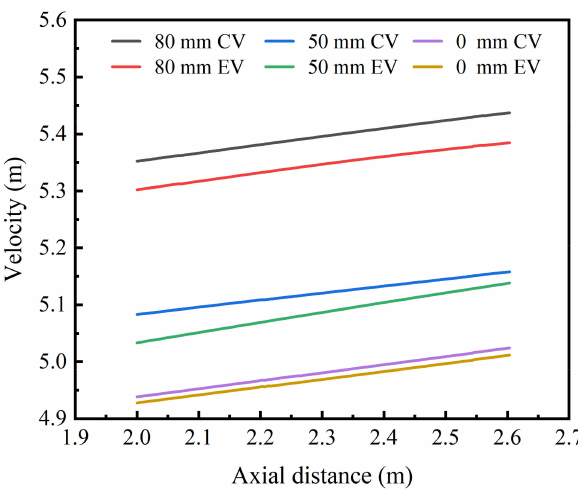
Figure 13. Calculated value is compared with the result value.